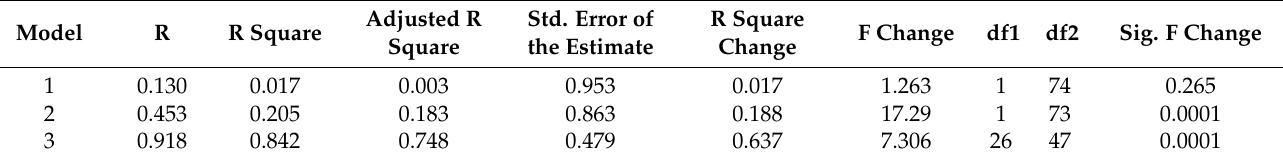
Table 3. Hierarchical multiple regression model summary.